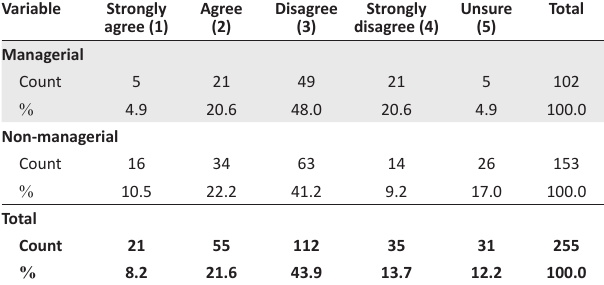
TABLE 7: Participants’ responses on the view that debt management strategies are effective.